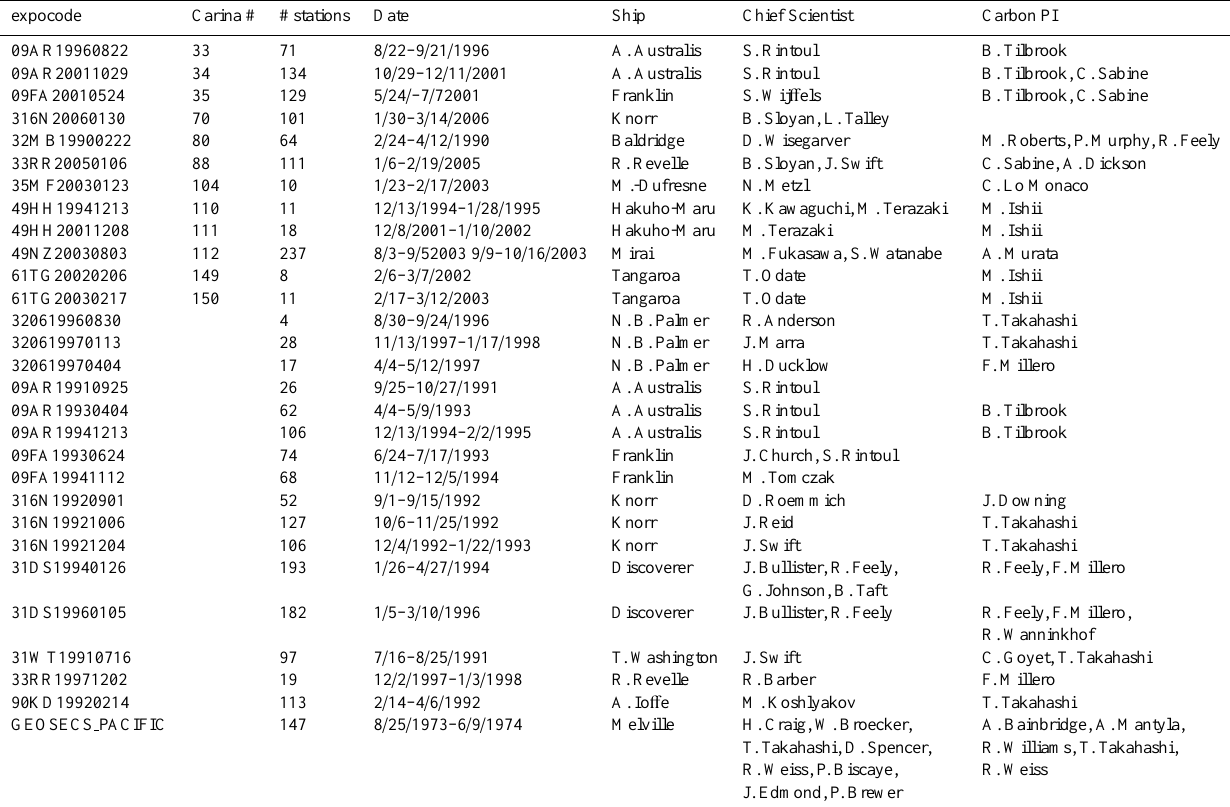
Table 1. Description of cruises included in Pacific sector of the Southern Ocean analysis.